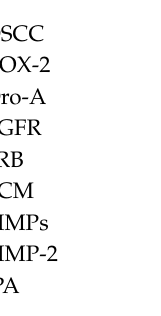
Table S1: Q-PCR primer; Figure S1: The effect of 24-h Oro-A exposure on LCN2, ID-1, MDK, S100A9, and CCL2 mRNA expression was determined by quantitative real-time polymerase chain reaction (Q-PCR); Figure S2: The effect of 24-h Oro-A exposure of on CCL2, CCR2, phosphorylated MER, IKK and P65 expression was determined by western